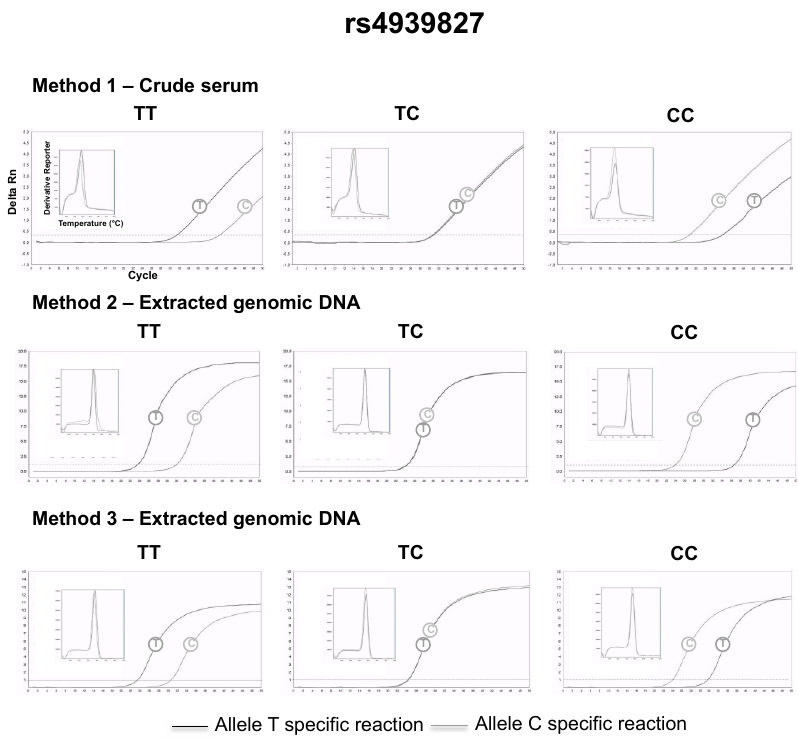
Figure 3. Representative rs439827 genotyping using method 1 (2 μ L of crude serum separated 4 h after the capillary blood collection), 2 and 3.